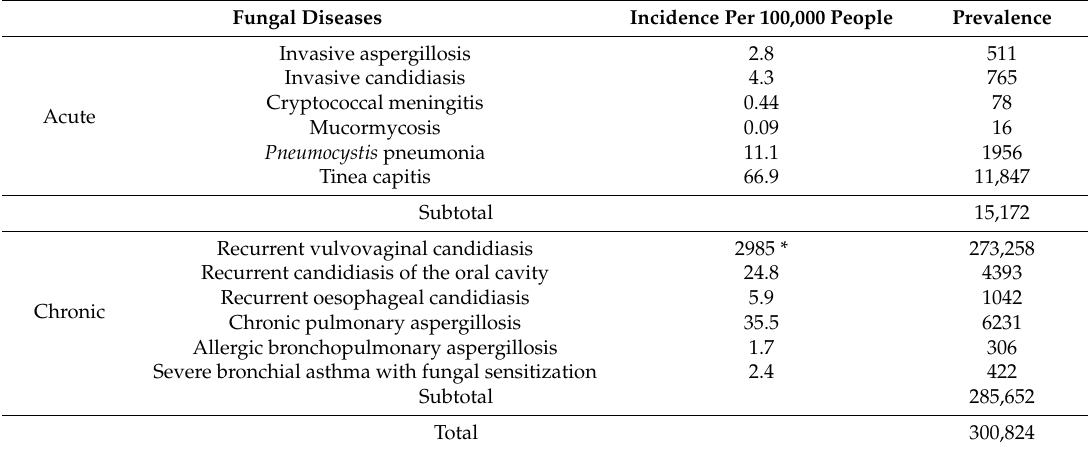
Table 1. Fungal diseases in the Republic of Kazakhstan (incidence and prevalence estimates for